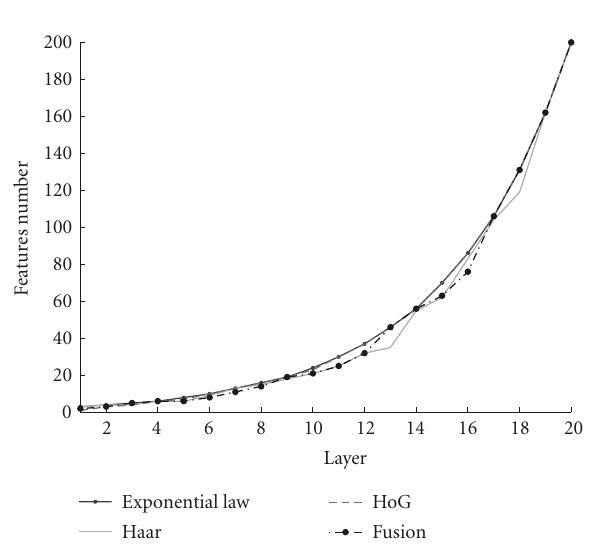
Figure 8: Number of features for the three detectors.